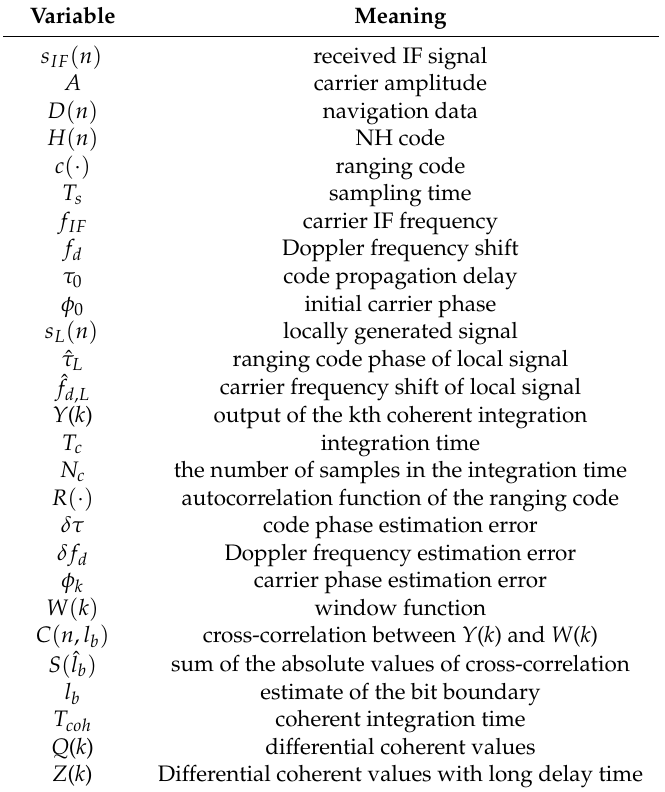
Table 1. Primary symbols and